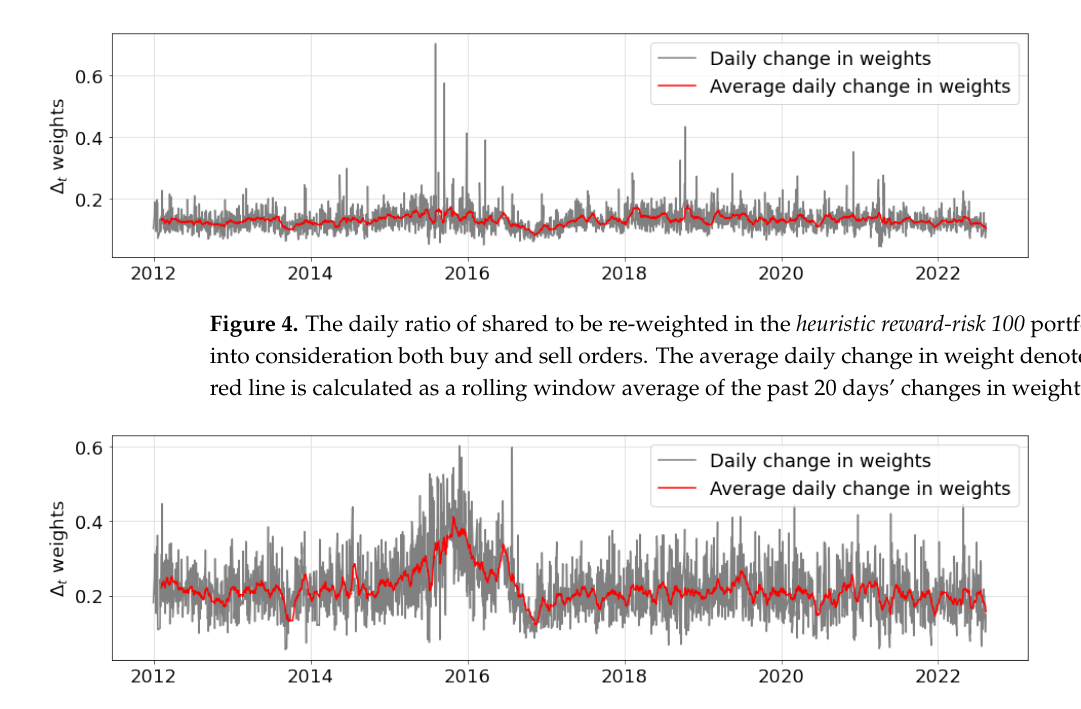
Figure 5. The daily ratio of shared to be re-weighted in the heuristic max-reward 100 portfolio, taking into consideration both buy and sell orders. The average daily change in weight denoted with the red line is calculated as a rolling window average of the past 20 days’ changes in weight.